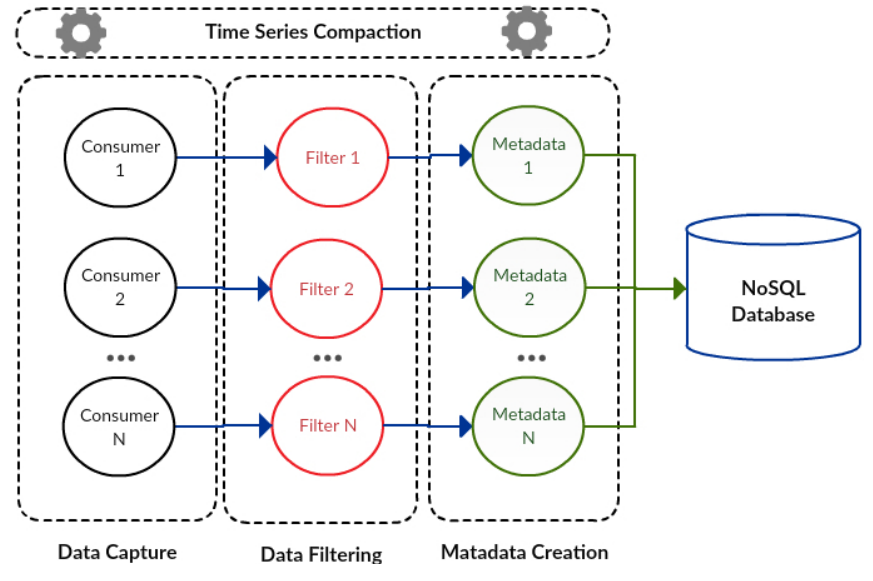
Figure 3. Data collection component.